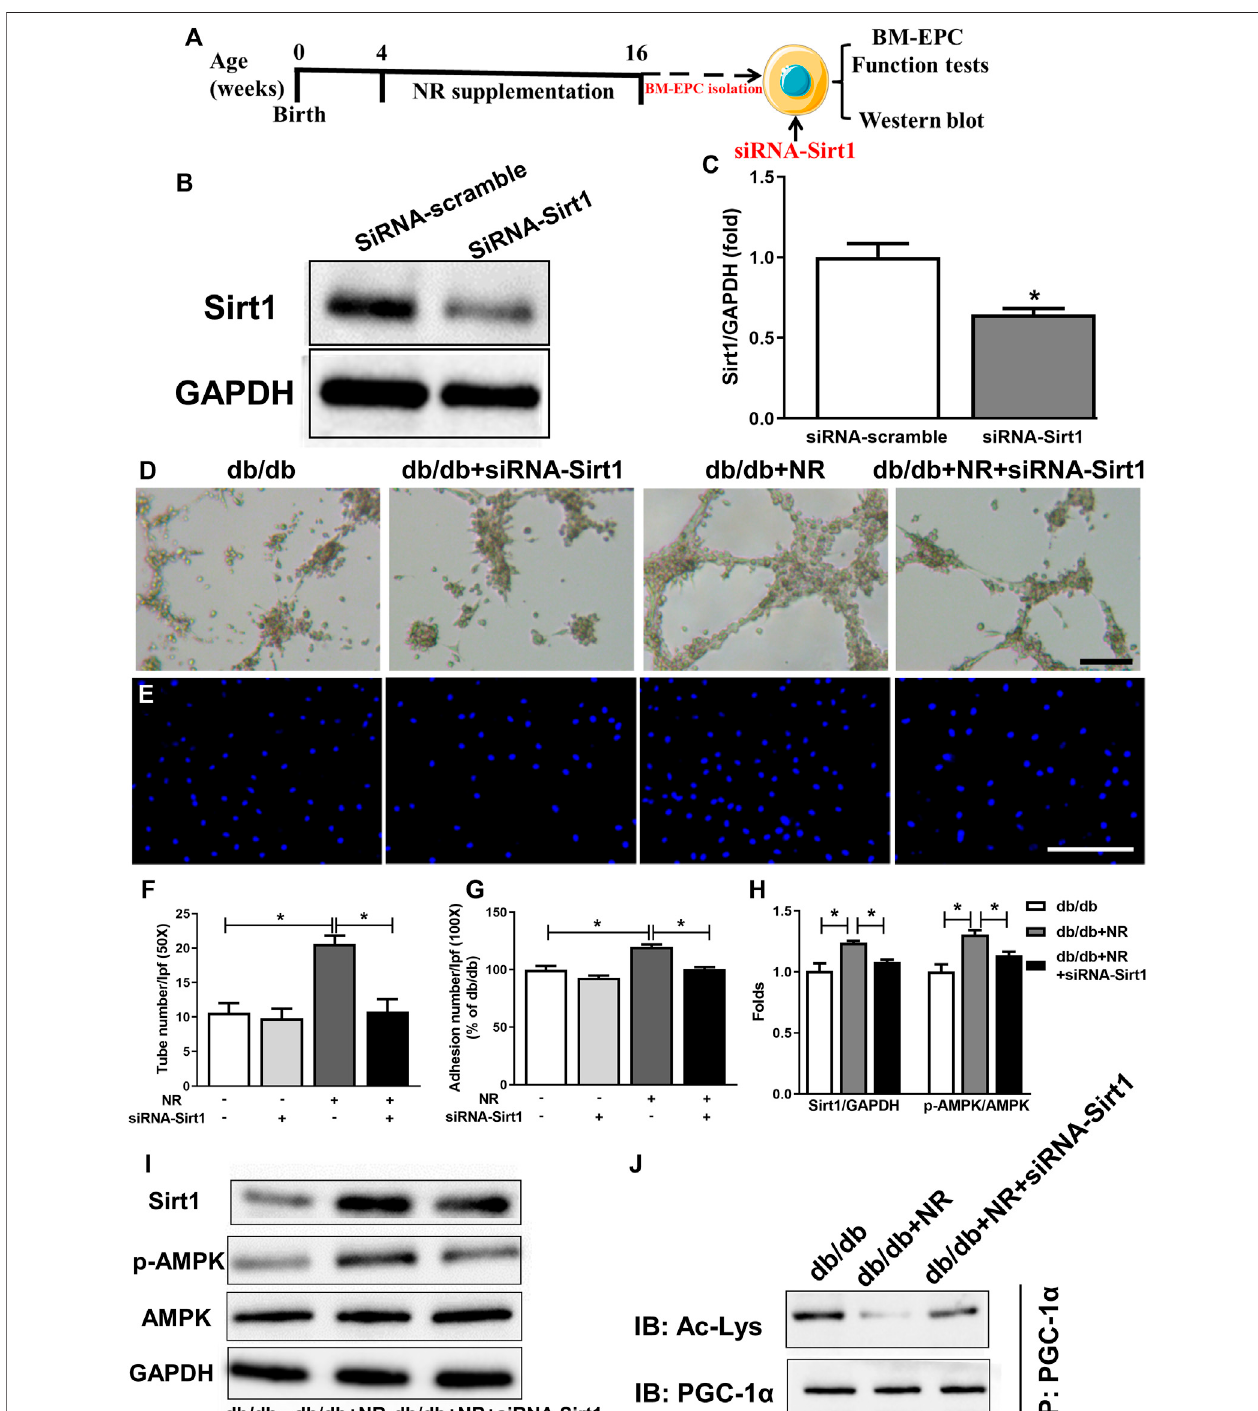
FIGURE 5 | Inhibition of Sirt1 with siRNA-Sirt1 abolished the protective effects of NR repletion on BM-EPC function in db/db mice. (A) Experimental schedule. Db/db mice received the NR supplied food for 12 weeks, and then, BM-EPCs were isolated and transfected with siRNA targeting Sirt1. (B,C) Transfection of siRNA – Sirt1obviouslyinhibitedSirt1expressioninBM-EPCsfrom db/db mice.* P < 0.05 vs. siRNA-Sirt1.Tubeformation (D) andadhesionabilitiesofBM-EPCs (E) were measured. Quantitative analysis of tube number (F) and adhesion number (G) . (H) Quantitative analysis of Sirt1, and p-AMPK expression was taken as in (I) . (I) Western blot of Sirt1/AMPK in BM-EPCs treated with NR in the presence or absence of siRNA – Sirt1. (J) Representative immunoblot images of acetylated PGC-1 α . D: 50 × ; scale bar, 100 μ m; E: 100 × ; scale bar, 100 μ m. Values are mean ± SEM, (B, C, H, I, J: n (cid:2) 3; D – G: n (cid:2) 5). * P < 0.05. BM-EPC, bone marrow – derived endothelial precursor cell; NS, no signi fi